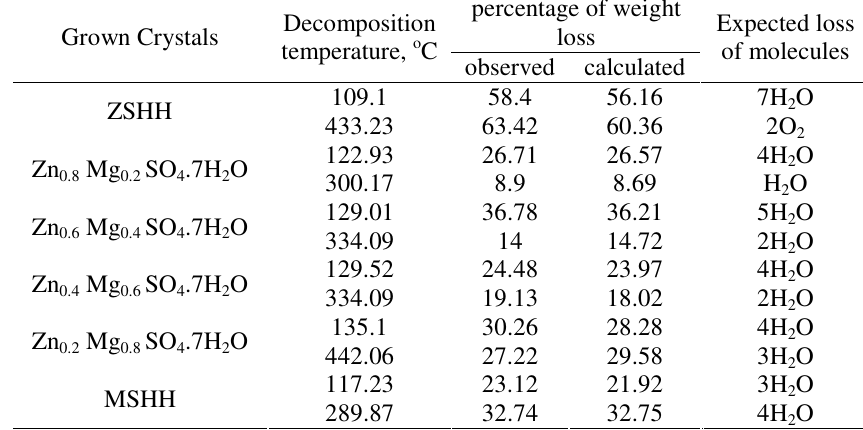
Table 4. Percentage of weight loss in the different stages of decomposition of (Zn-Mg)SHH mixed